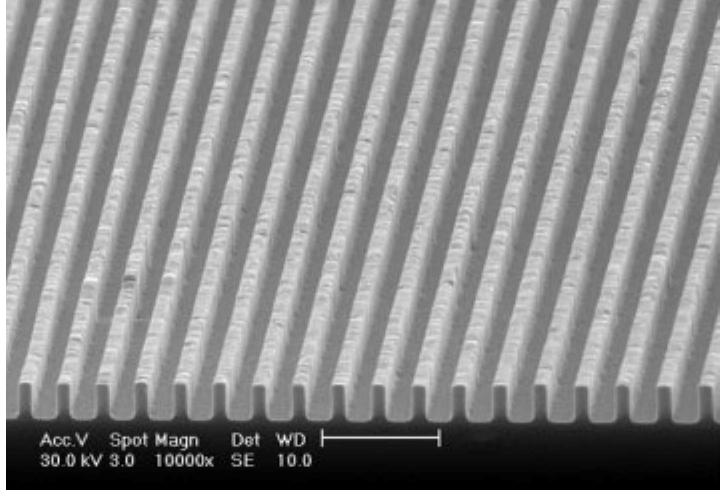
Figure 12. Pseudo-self-healing demonstration of bisected specimen of ExSil ® (Author’s work).